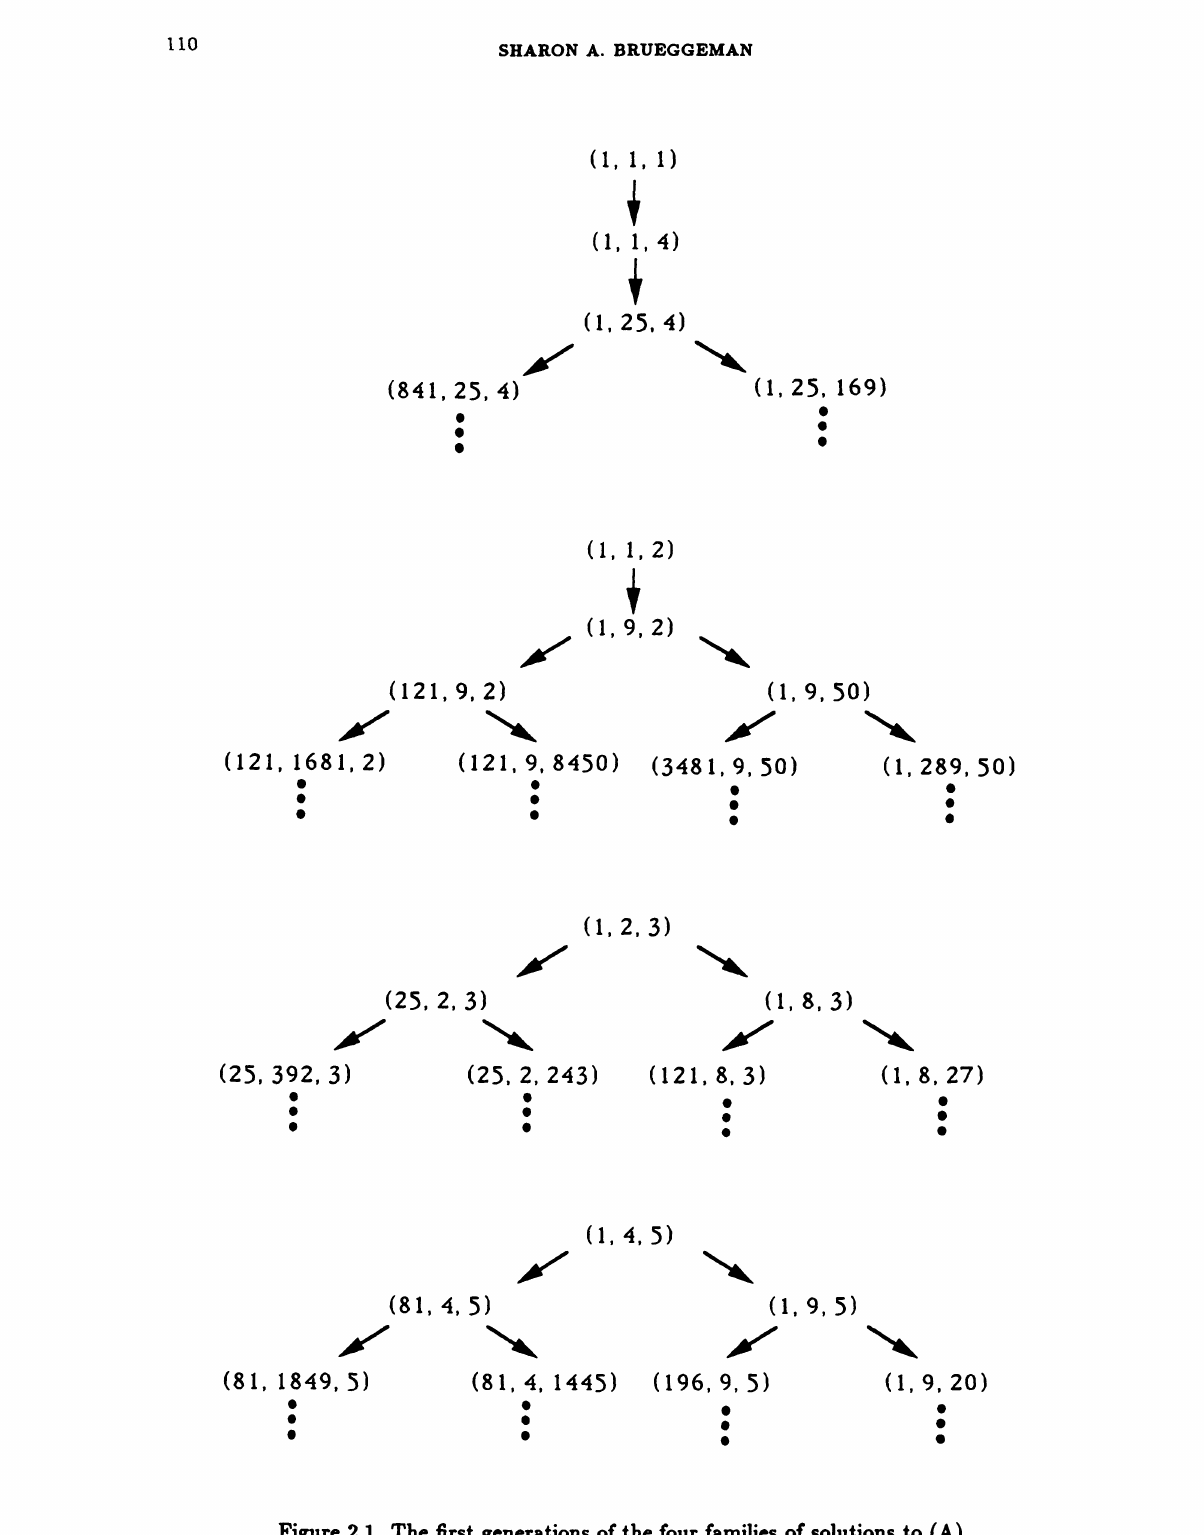
Figure 2.1. The first generations of the four families of solutions to